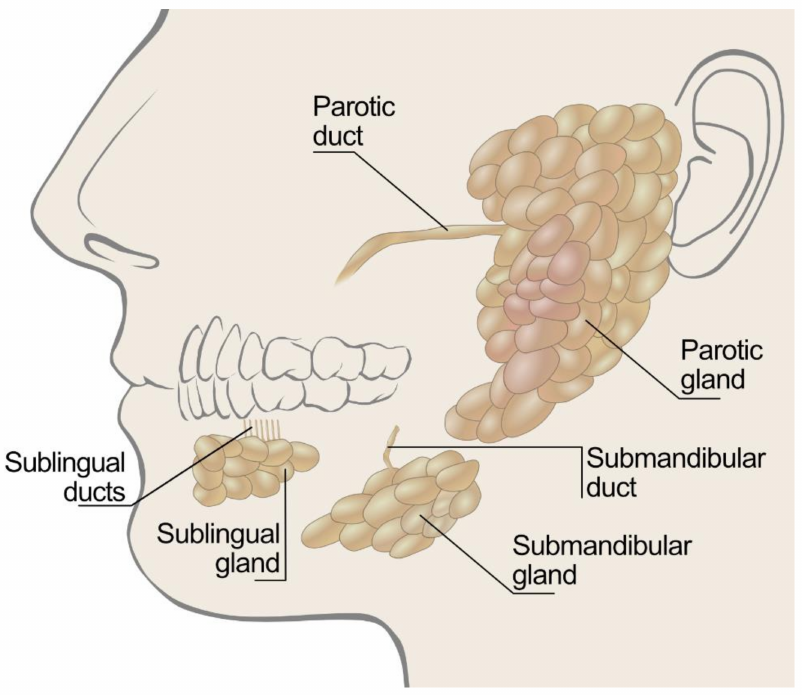
Figure 1. Illustration of salivary glands types and